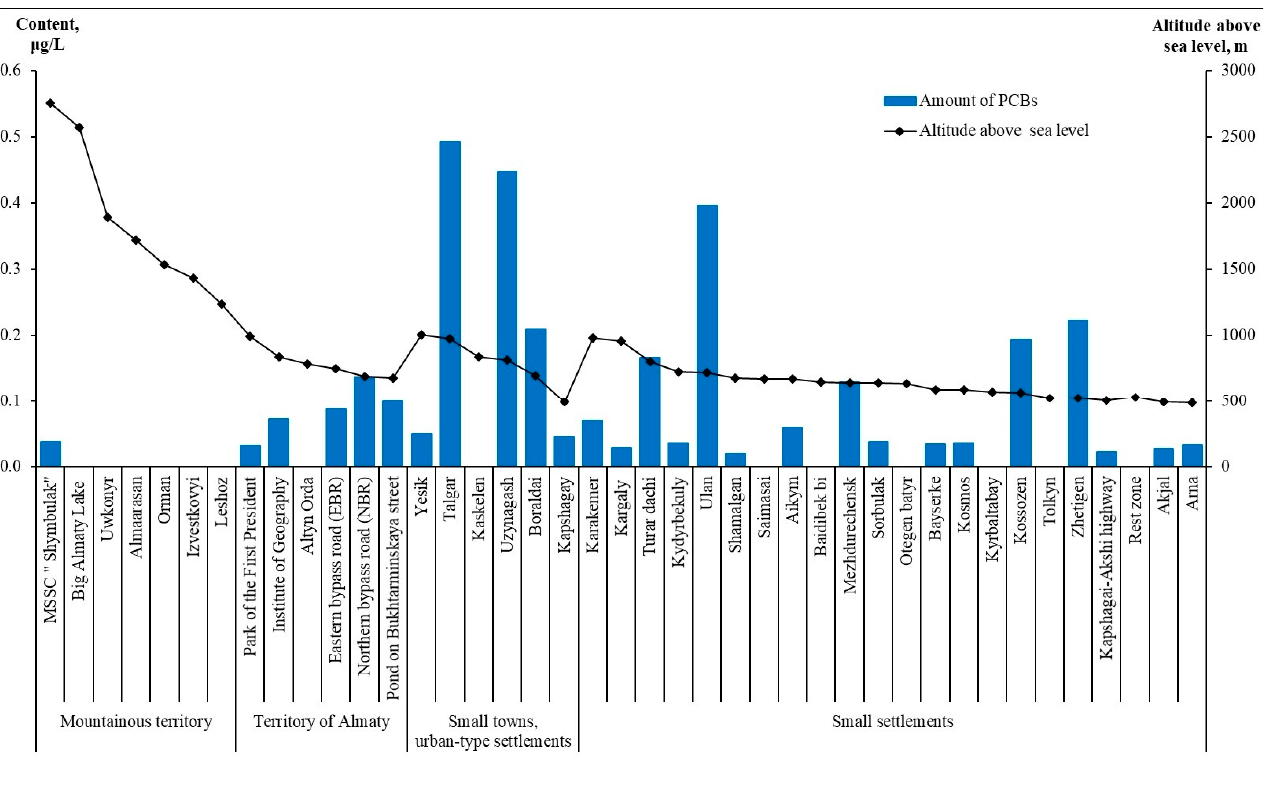
Figure 6. Content of PCBs in the snow cover of Almaty agglomeration (AA) depending on the al- titude. the